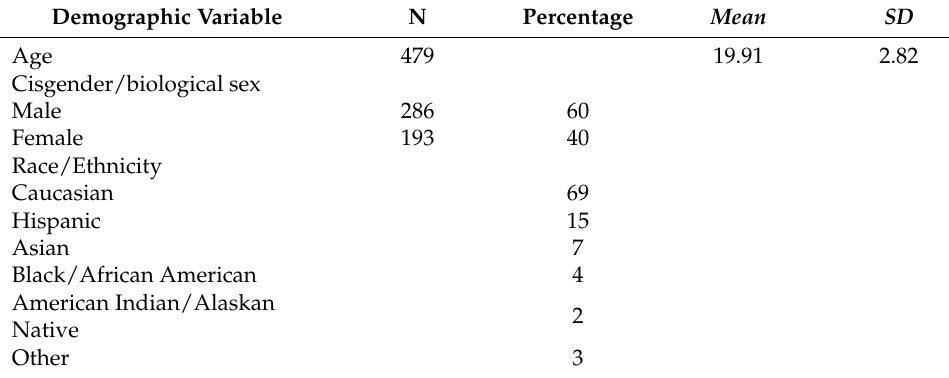
Table 1. Demographic variables for all participants.